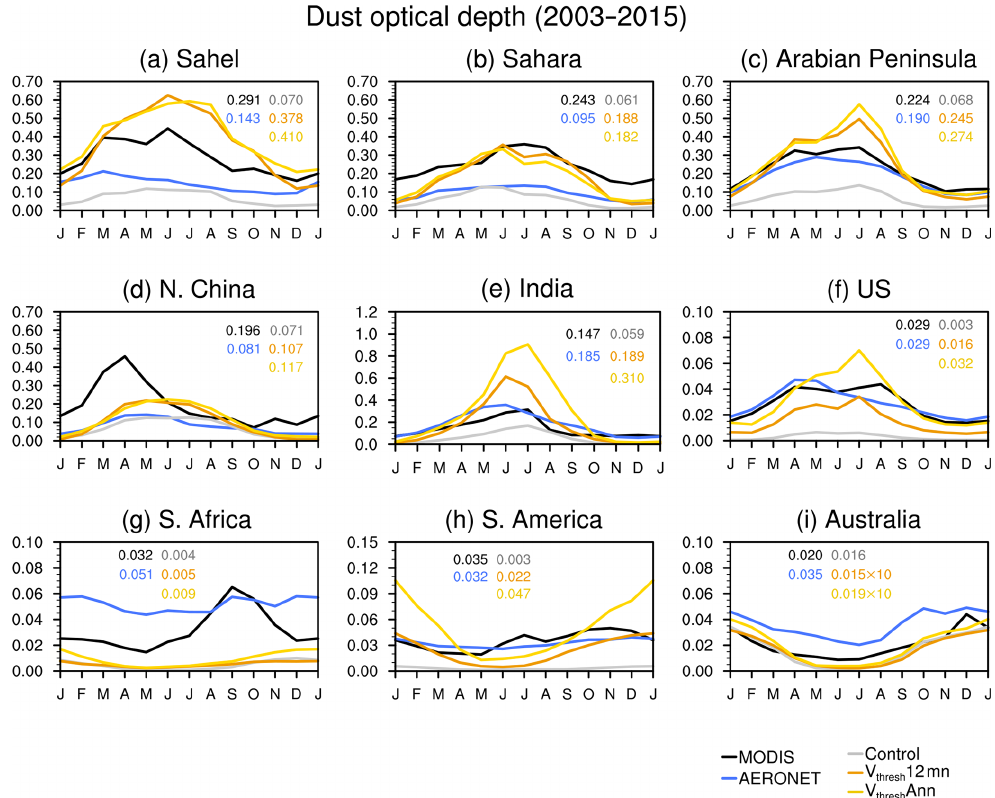
Figure 11. Seasonal cycle of DOD from MODIS (black), the Control (grey), V thresh 12mn (orange), and V thresh Ann (yellow) runs, with gridded AERONET SDA COD (blue) averaged over nine regions. The annual mean of each dataset in each region is listed on the top of the plot. Note that in (i) DOD from the V thresh 12mn and V thresh Ann simulations is multiplied by 0.1 for